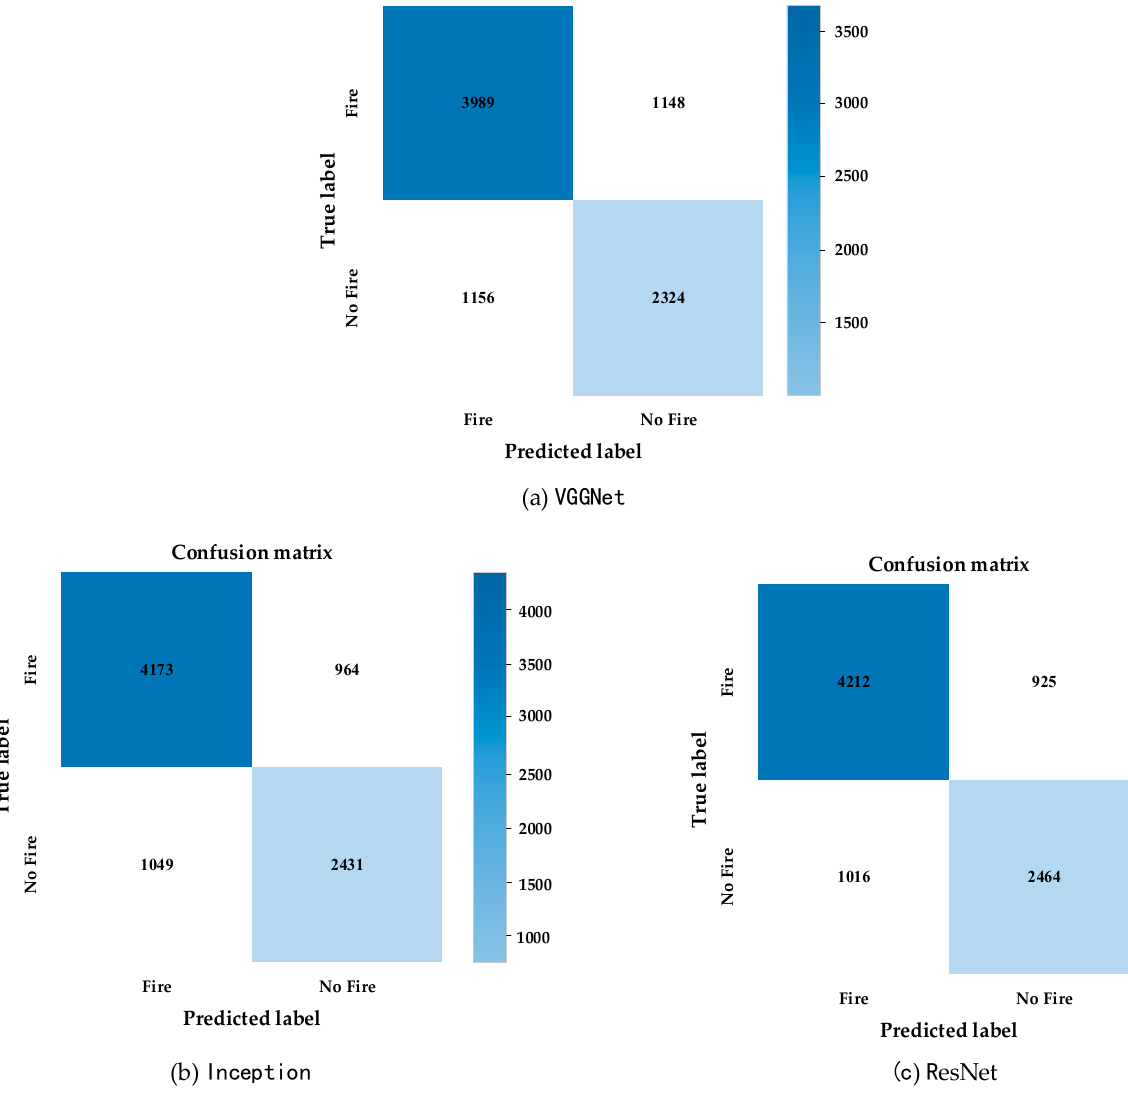
Figure 10. Comparison of confusion matrix of different backbone networks.